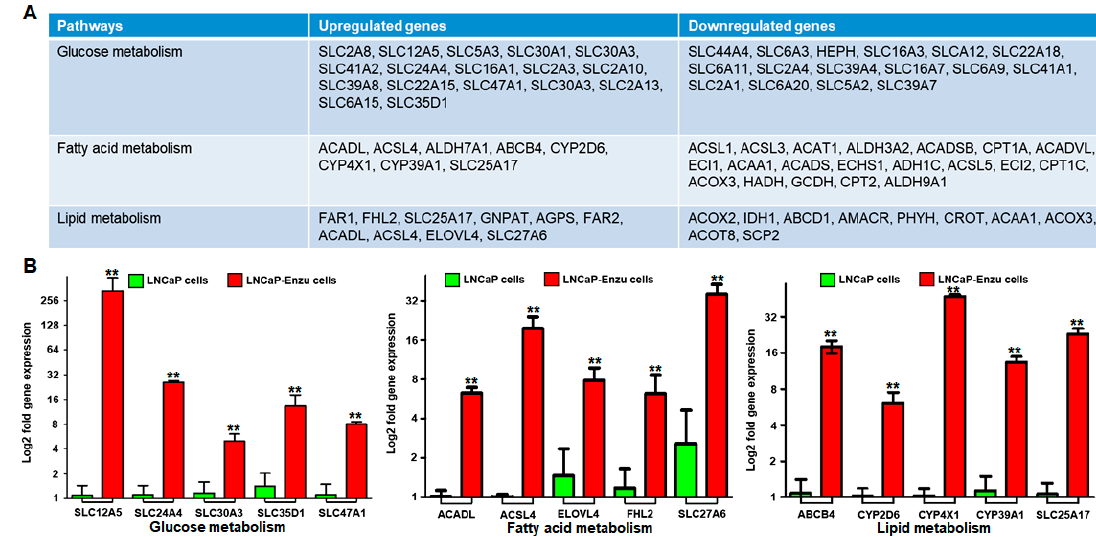
Figure 7. ( A ) Alteration in gene expression associated with the regulation of glucose, fatty acid, and lipid metabolism in LNCaP (parental) and LNCaP enzalutamide resistant cells. ( B ) Real time PCR validation of genes of glucose metabolism SLC12A5 , SLC24A4 , SLC30A3 , SLC35D1 , and SLC47A1 ; fatty acid metabolism ABCB4 , CYPD6 , CYP4X1 , CYP39A1 , and SLC25A17 ; and lipid metabolism ACADL , ACSL4 , ELOVL4 , FHL2 , and SLC27A6 . The qRT-PCR data were analyzed between LNCaP versus LNCaP-enzalutamide resistant cells using (delta-delta CT method; fold = 2 − ∆∆ CT ). Bar represents the standard error mean (SEM) for three biologicals and three technical replicates. ** p < 0.001, LNCaP versus LNCaP enzalutamide resistant cells.